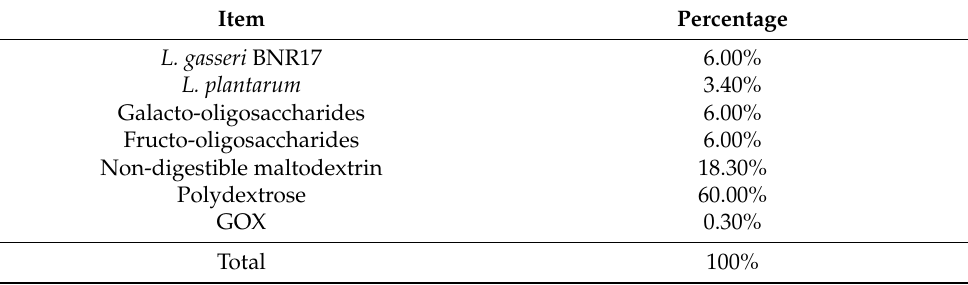
Table 2. Composition and proportions of symbiotic preparation in this